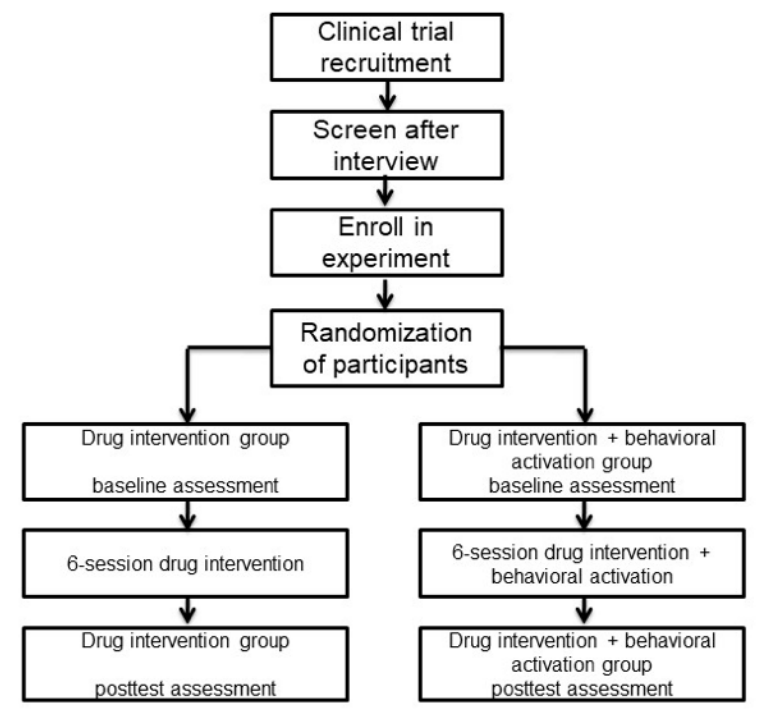
Figure 1. Study design of guided self-help behavior activation intervention for geriatric